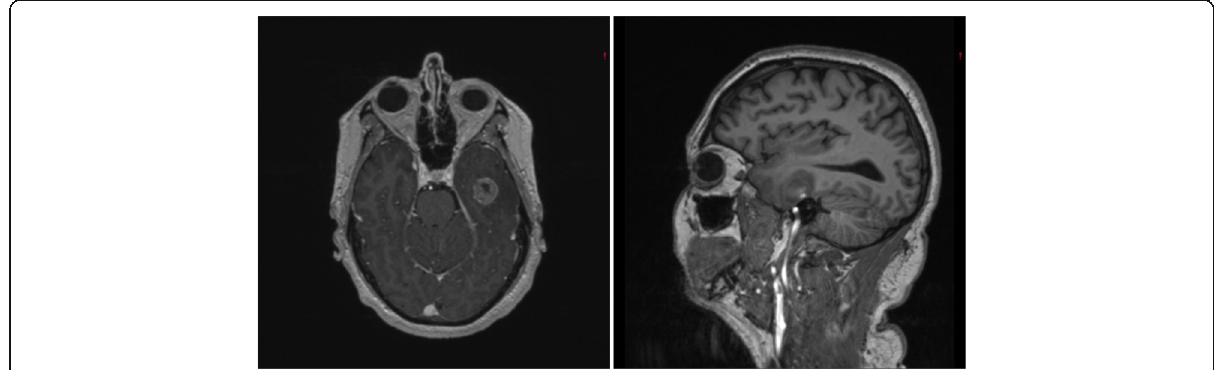
Fig. 1 Magnetic resonance (MR)-imaging at initial evaluation at outside institution. T1-weighted post-contrast MR-imaging in the axial ( Left ) and sagittal ( Right ) planes demonstrating a contrast-enhancing lesion (maximum diameter 2.1 cm) that stereotactic needle biopsy confirmed to be glioblastoma multiforme. After biopsy, the patient underwent laser interstitial thermal therapy of the enhancing